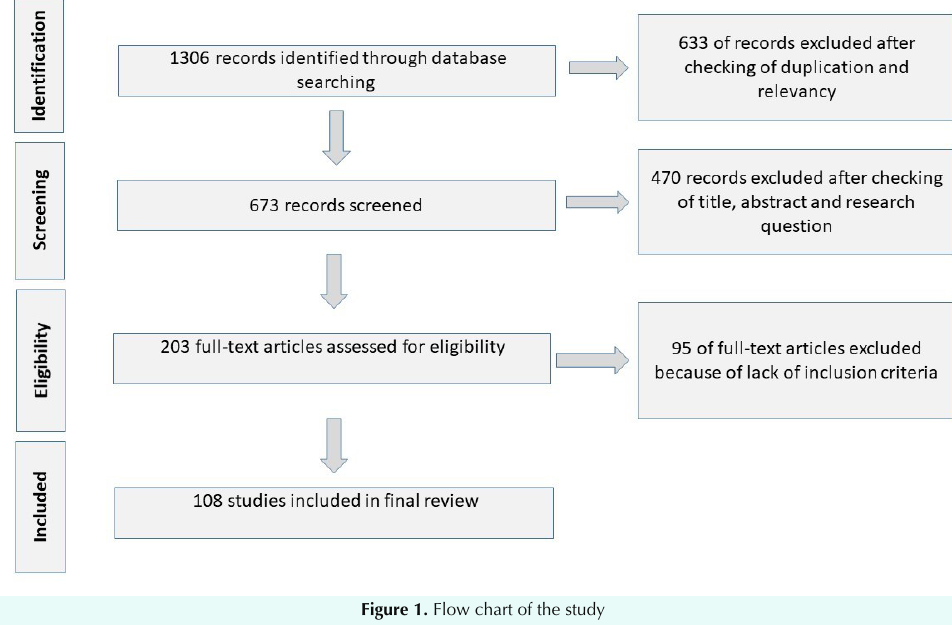
Figure 1. Flow chart of the